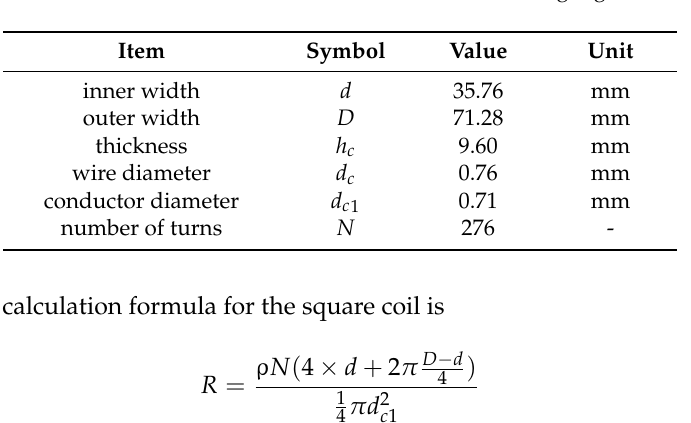
Table 1. The actual sizes of coil and the conductor gauge.